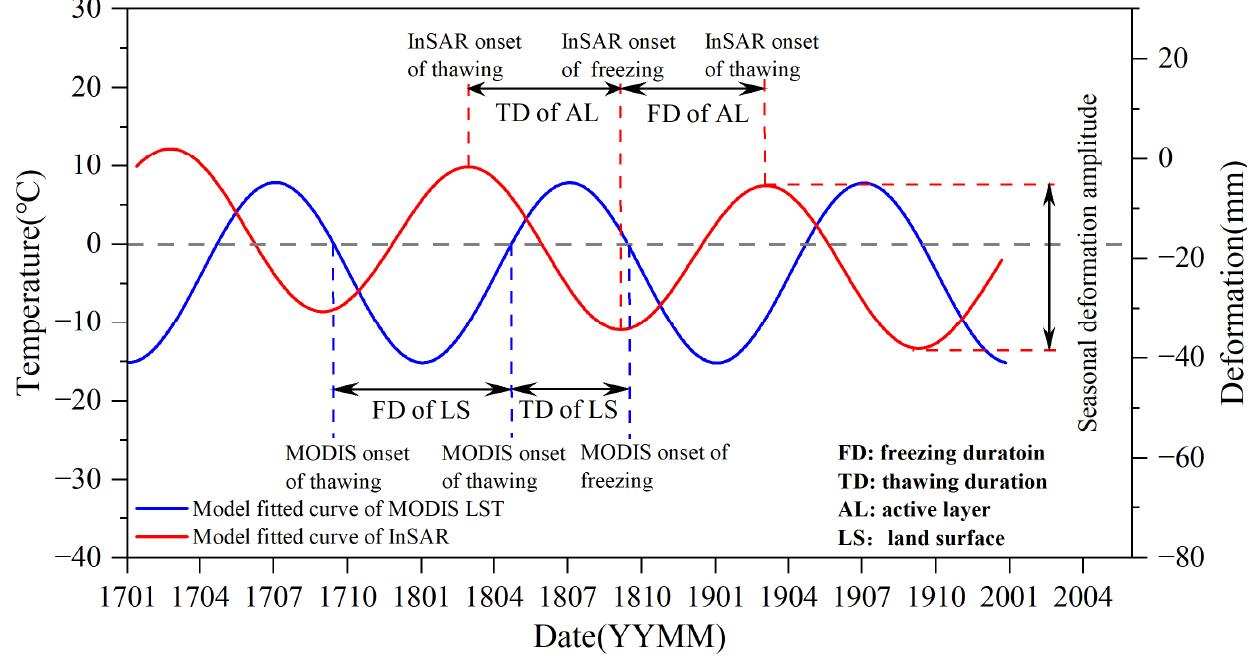
Figure 3. The time characteristics of seasonal deformation of the ZL05.